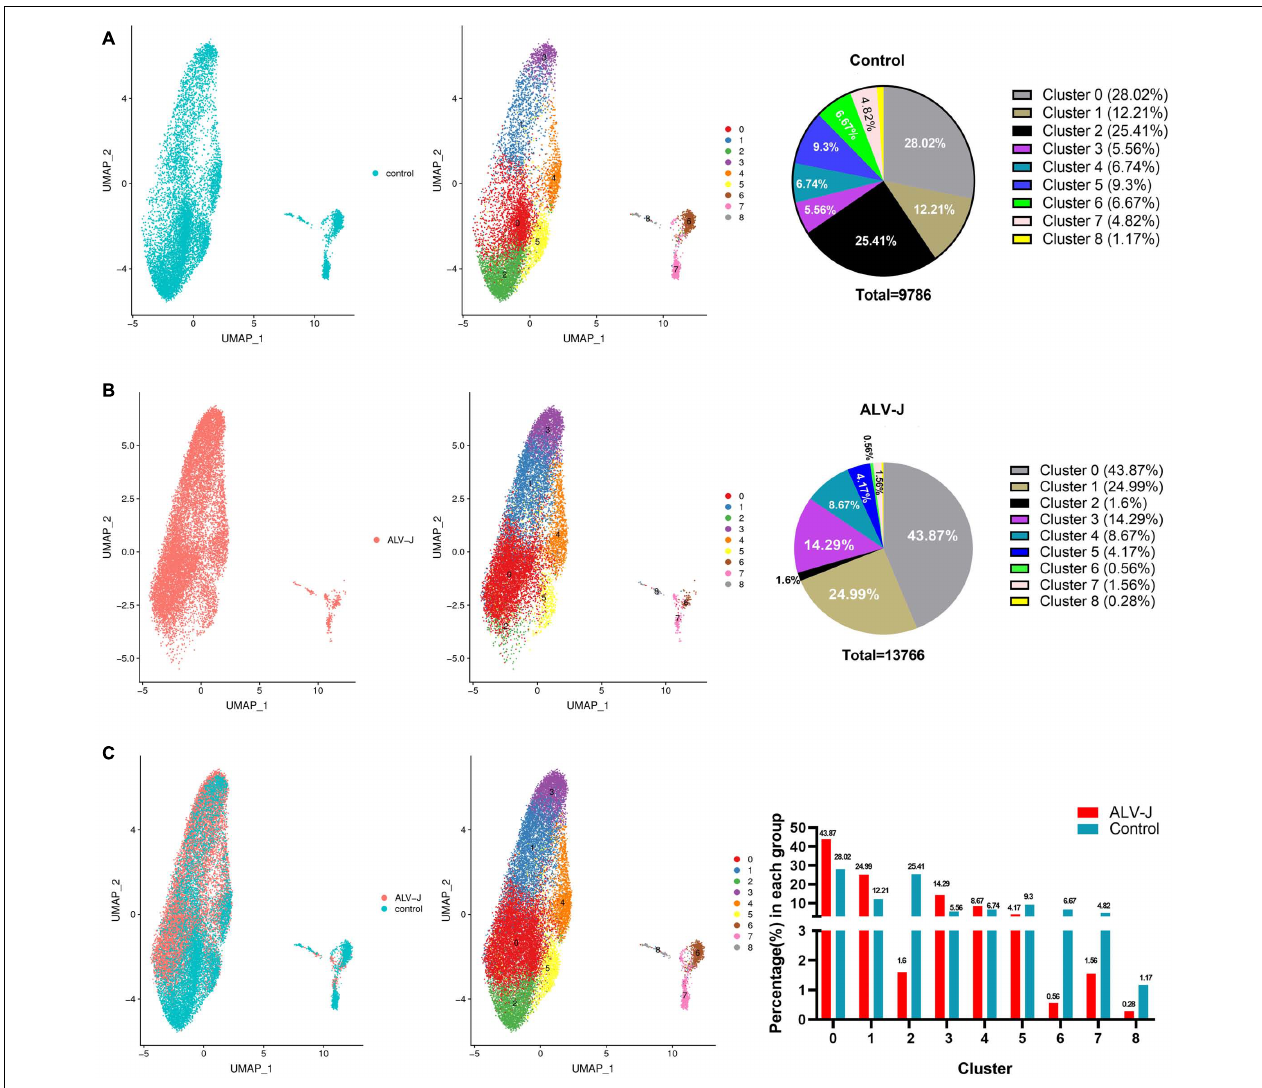
FIGURE 1 | Single-cell profiling of cell populations in chicken peripheral blood mononuclear cells (PBMCs) collected from avian leukosis virus subgroup-J (ALV-J)-infected and control chickens at 21 days post infection (DPI). (A) Uniform Manifold Approximation and Projection (UMAP) display of all cell populations and their proportions in the control PBMCs. (B) UMAP display of all cell populations and their proportions in PBMCs from ALV-J infected chicken. (C) Cell distribution and proportion of each cluster in PBMCs from ALV-J infected and control